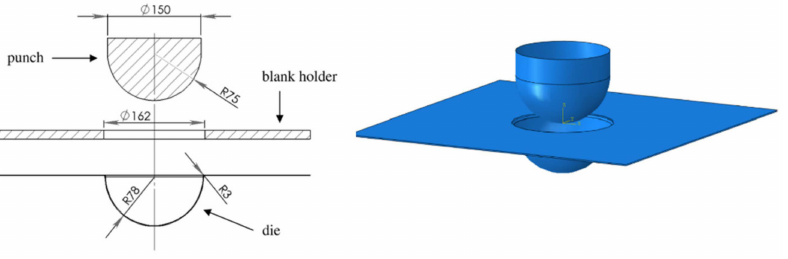
Figure 10. Hemispherical tool design.